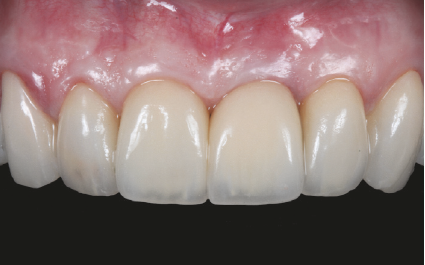
Figure 11: Stable results were obtained after four years of follow-up of the zenith-driven